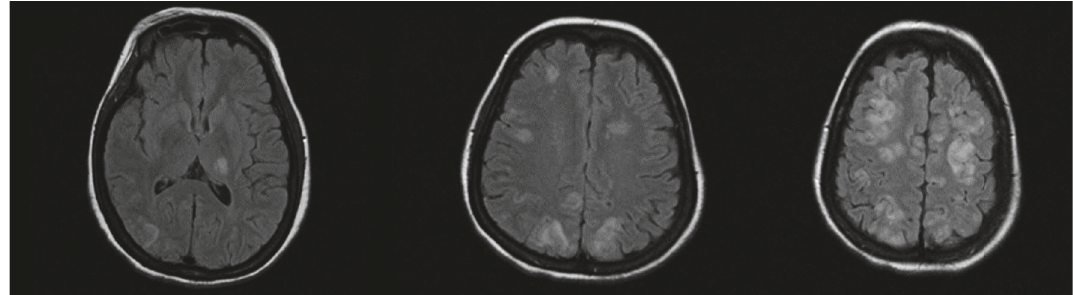
Figure 1: Case No. 1. Flair sequences showing multiple areas of hyperintensity in left thalamus and occipital and frontal lobes, extended to grey matter of the cortex.